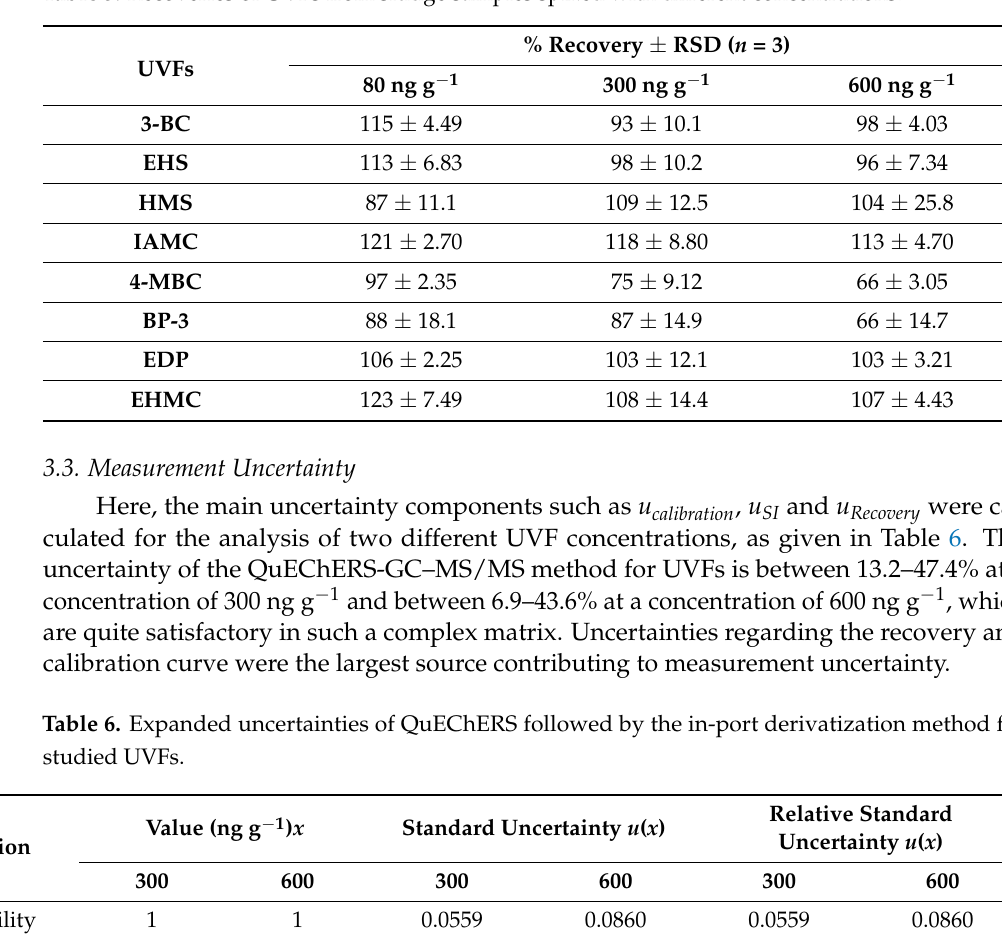
Table 5. Recoveries of UVFs from sludge samples spiked with different concentrations.